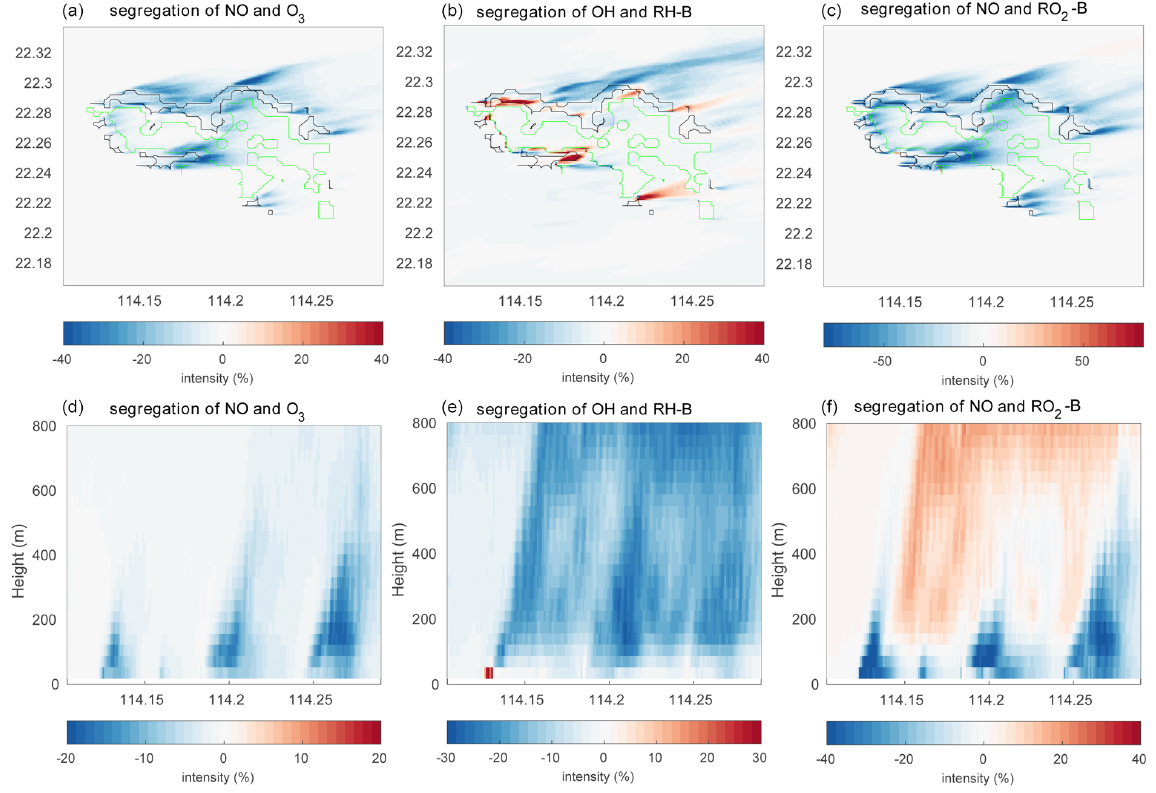
Figure 7. Segregation intensities at the first level (a–c) and the vertical cross section along latitude 22.275 ◦ N (d–f) at hour 4 for the HETF case. The black line shows the urban area, and the green line shows the forest